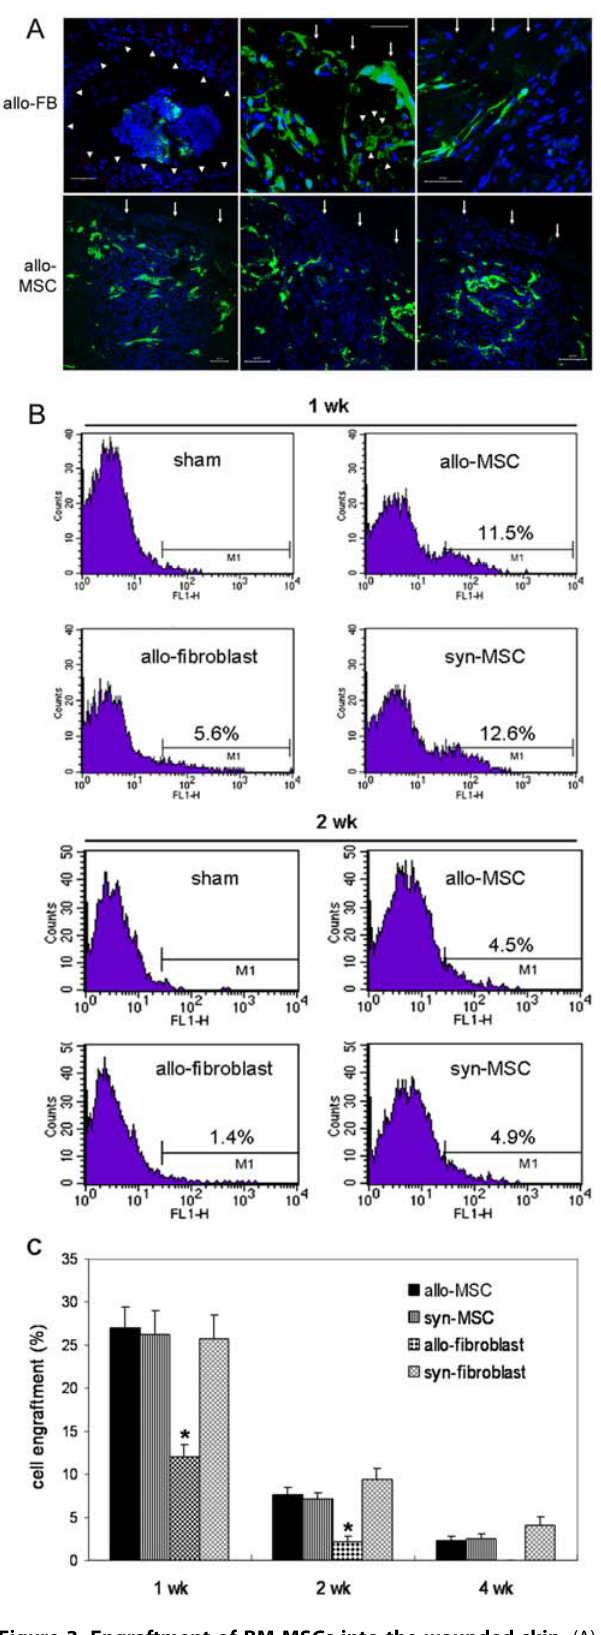
Figure 3. Engraftment of BM-MSCs into the wounded skin. (A) Allo-fibroblasts or allo-MSCs in wounds. Representative fluorescence microscopic images of day 7 wound sections showing that the injected